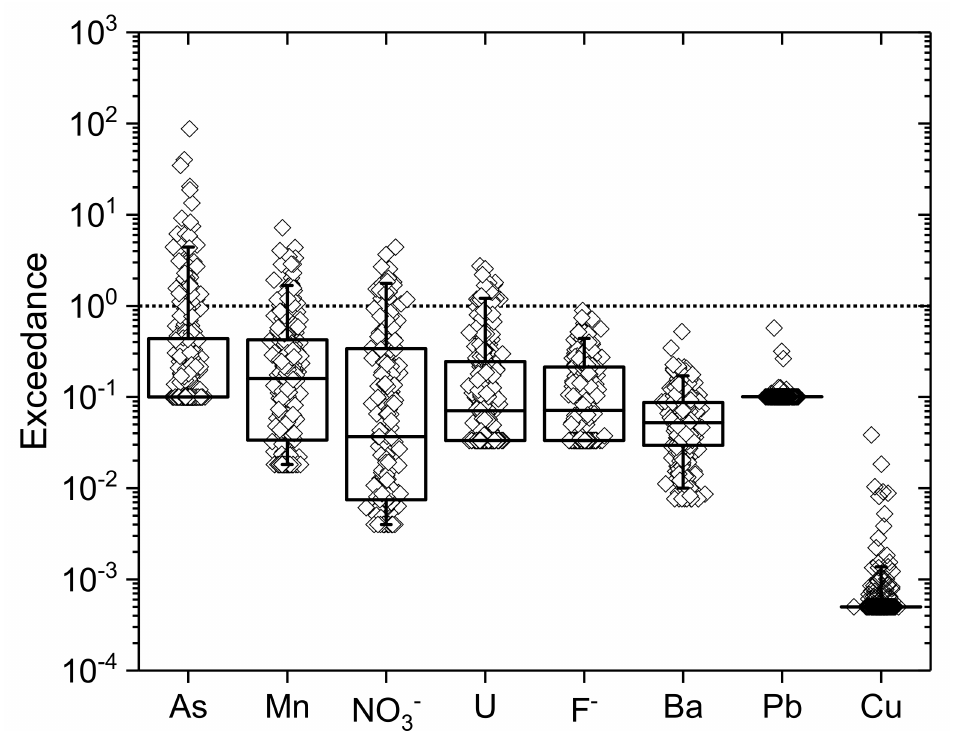
Figure 4. Exceedance plot for measured concentrations against WHO guideline values for As (0.13 µ M; 10 µ g.L − 1 ; provisional), Mn (0.01 mM; 0.4 mg.L − 1 ; former / discontinued), NO 3 − (0.806 mM; 50 mg.L − 1 ), U (0.13 µ M; 30 µ g.L − 1 ; provisional), F − (0.079 mM; 1.5 mg.L − 1 ), Ba (0.0095 mM; 1.3 mg.L − 1 ), Pb (0.048 µ M; 0.01 mg.L − 1 ; provisional) and Cu (0.032 mM; 2 mg.L − 1 ). Exceedance was calculated by dividing measured concentrations by the relevant WHO guideline. Exceedance > 1 indicates the number of samples above guideline values for each parameter (samples with measured concentrations below detection for a particular analyte were calculated based on maximum concentration at method detection limit for inclusion in exceedance plots). Median is line within box; boxes indicate the 25–75 percentile distribution, whiskers indicate the 5 and 95 percentile distribution. Where median or lower whiskers are not clearly seen there are high numbers of samples below